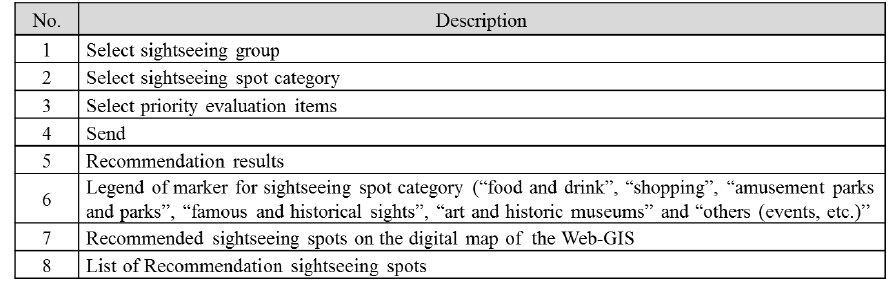
Figure 5. Pages for the recommendation function of sightseeing spots.